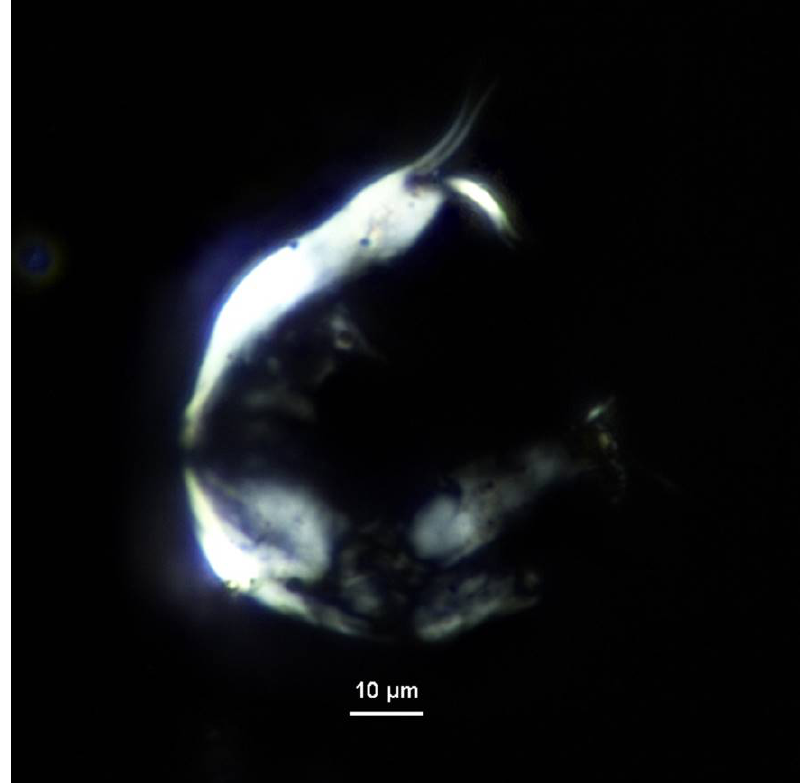
Figure 12. Recovered cooking or arching-damaged starch grain: polarized Artefact 6, point sample 2 at 400x.